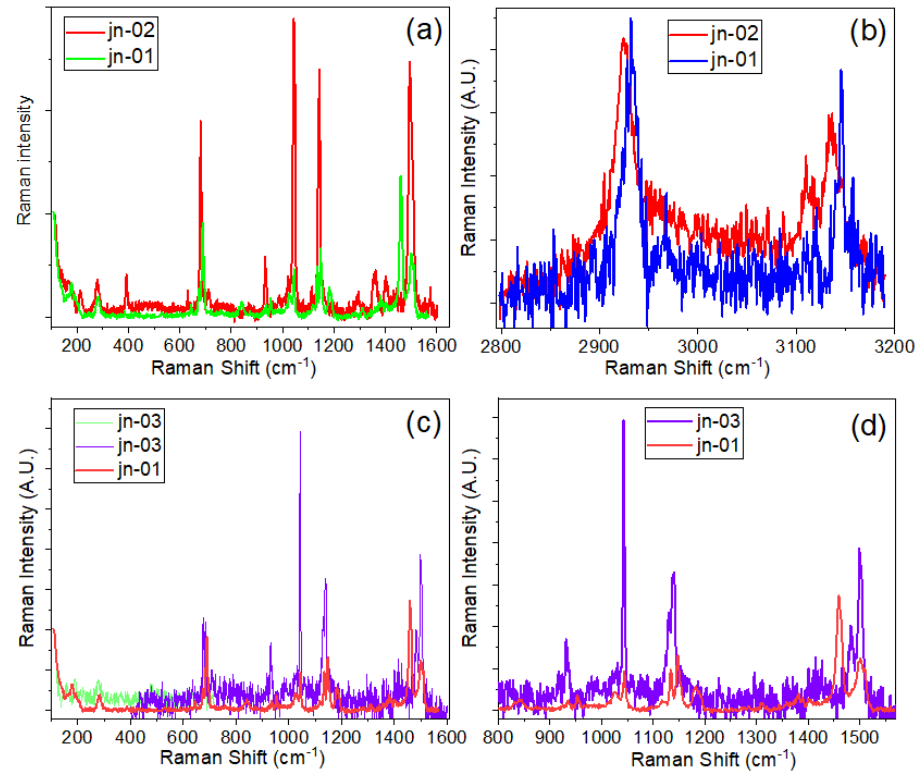
Figure 5. Comparison of Raman spectra of pure ZIF-L/-8 (jn-01) powder sample and ZIF-8 impreg- nated into ( a , b ) unetched (jn-02) and ( c , d ) etched (jn-03) pores of MCG plates shown in different regions. More detailed spectral presentation can be seen in Figure S6.